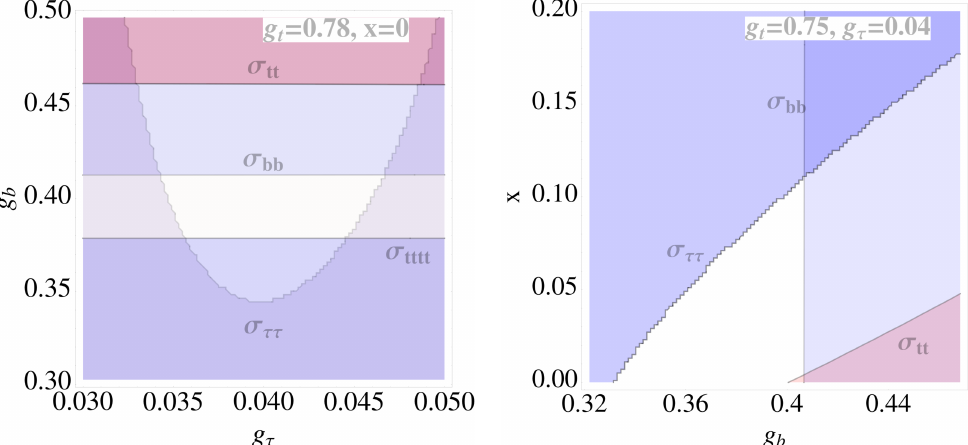
Figure 3 . Production cross-section predictions of relevant 400-GeV pseudoscalar channels with 1 σ uncertainties in the [ g , g ] (with g = 0.78 and x = 0) and [ g τ b t planes, left and right, respectively. Each contour line is labeled with the 1 σ cross-section value of the considered corresponding channel. Blue and red shaded areas are excluded by